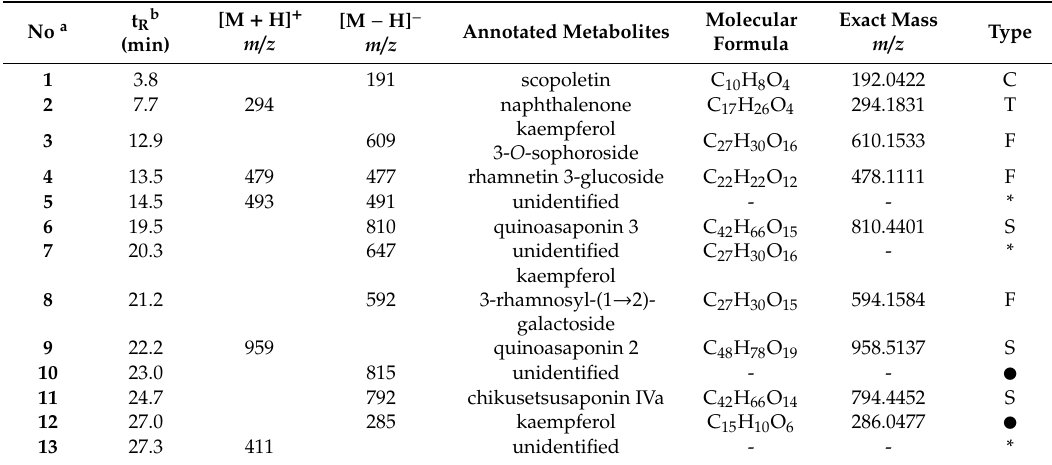
Table 1. Peak annotations in Chenopodium quinoa -derived extracts after LC/MS analysis.